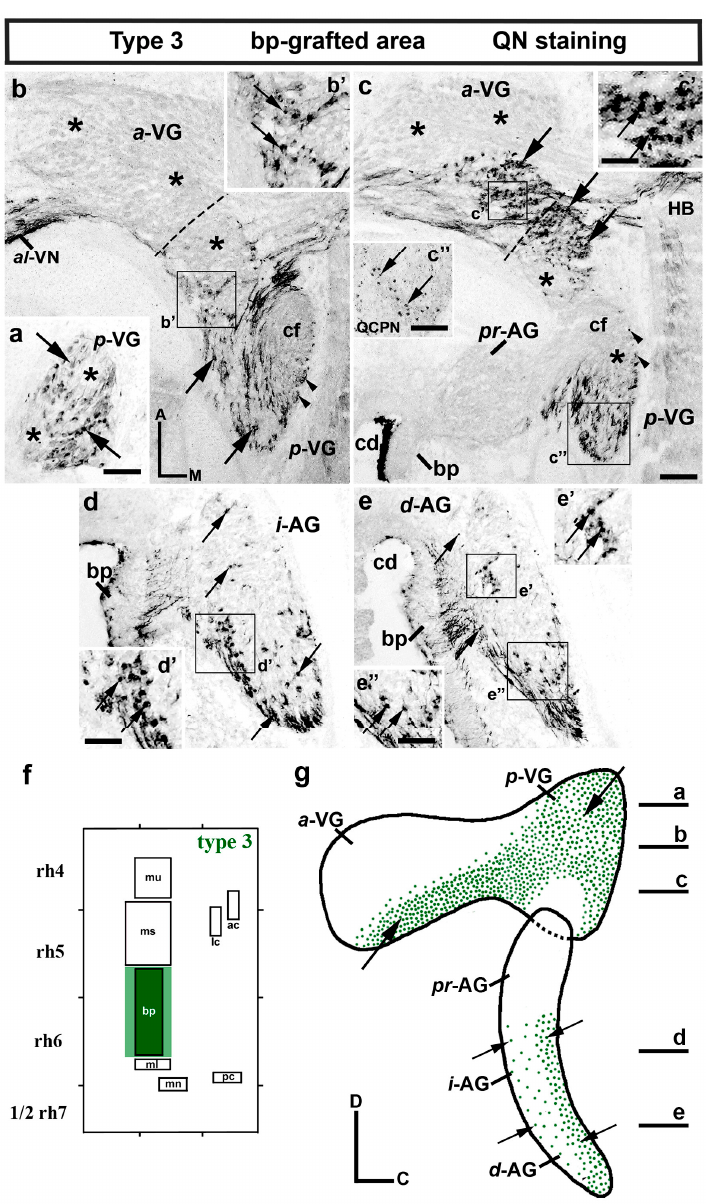
Figure 3. Graft-derived quail ganglionic neurons from the extended area of the basilar papilla (type-3 grafts; n = 8). ( a – e ) Horizontal sections stained with QN antibodies through the vestibular (VG in ( a – c’’ )) and acoustic (AG in ( c – e’ )) ganglia. The do tt ed lines in b and c de fi ne the separation between the anterior and posterior lobes of the VG ( a -VG and p -VG). QN-stained grafted quail neurons were detected in the vestibular ganglion ( a -VG and p -VG; arrows in ( a – c’’ )) and in the i -AG and d -AG (arrows in ( d – e’ )). The insert ( c’’ ) con fi rms the presence of QCPN-stained neurons in the p -VG. ( a – c ) The asterisks indicate the areas of the VG devoid of bp-grafted neurons. ( b ) The arrowheads point to axons in the cochlear fascicle (cf). ( f ) Schematic representation of type-3 grafts performed at the 10-somite stage, considering the expanded sensory area of the basilar papilla (bp; dark and light green areas). ( g ) Diagram summarizing these results, in which horizontal sections are indicated. The arrows point to the most signi fi cant accumulations of grafted quail neurons. Orientation: A, anterior; C, caudal; D, dorsal; M, Medial. Additional abbreviations: al -VN, anterolateral vestibular nerve; bp, basilar papilla; cd, cochlear duct; HB, hindbrain. Scale bar = 14 µm in ( a ); 18 µm in ( b , c ); 6.5 µm in ( b’ , c’ ); 12 µm in ( d ); 7 µm in ( d ’); 15 µm in ( e ); 10 µm in ( e’ , e’’ ). The study of type-4 chimeric embryos, which correspond to the expanded sensory areas of both the macula lagena and macula neglecta (topologically the two most posterior